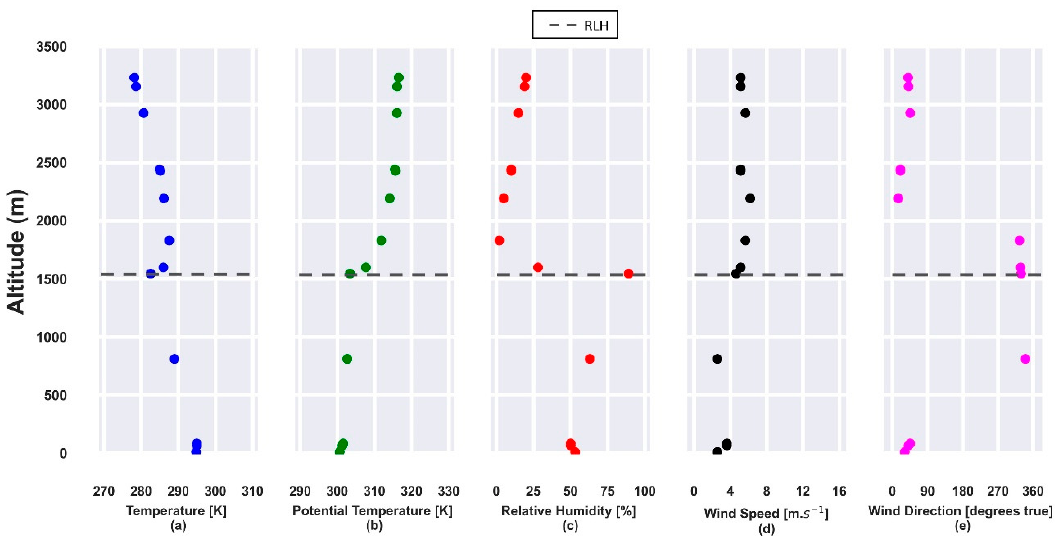
Figure 3. Atmospheric parameters obtained from radiosonde data on 23 July 2019 at 00:00 UTC. ( a ) Temperature [K]; ( b ) potential temperature [K]; ( c ) relative humidity [%]; ( d ) horizontal wind speed [m · s − 1 ]; ( e ) wind direction [degrees true]. The gray dashed line represents the RLH.